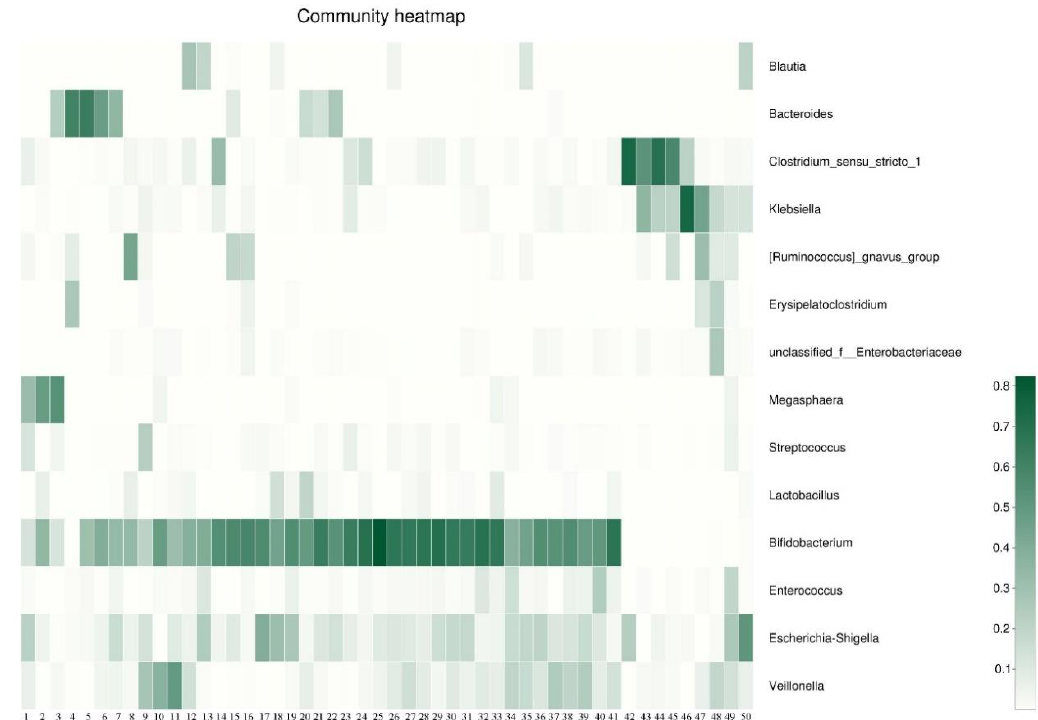
Figure 1. Relative abundance (≥1%) of infant gut microbiota at the genus level in the differentiation of the microbiota of six-month old infants. ** Each bar represents one sample.